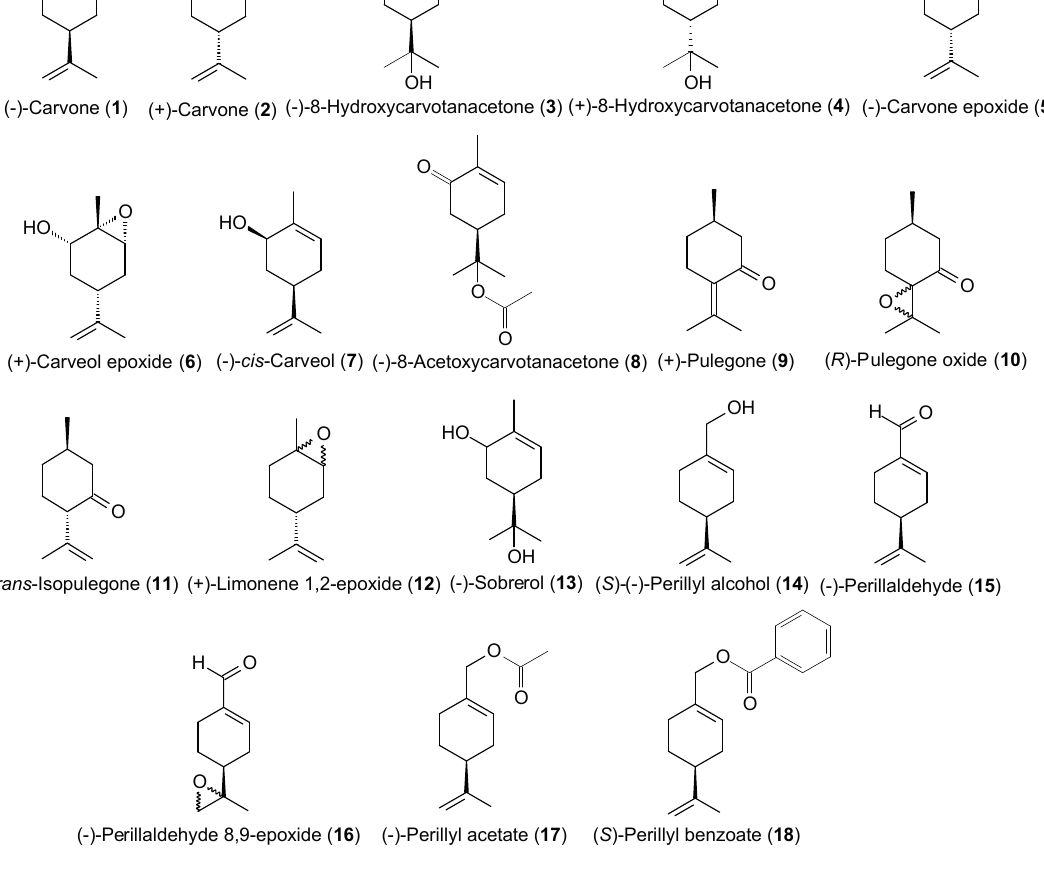
Figure 1. Structures of evaluated